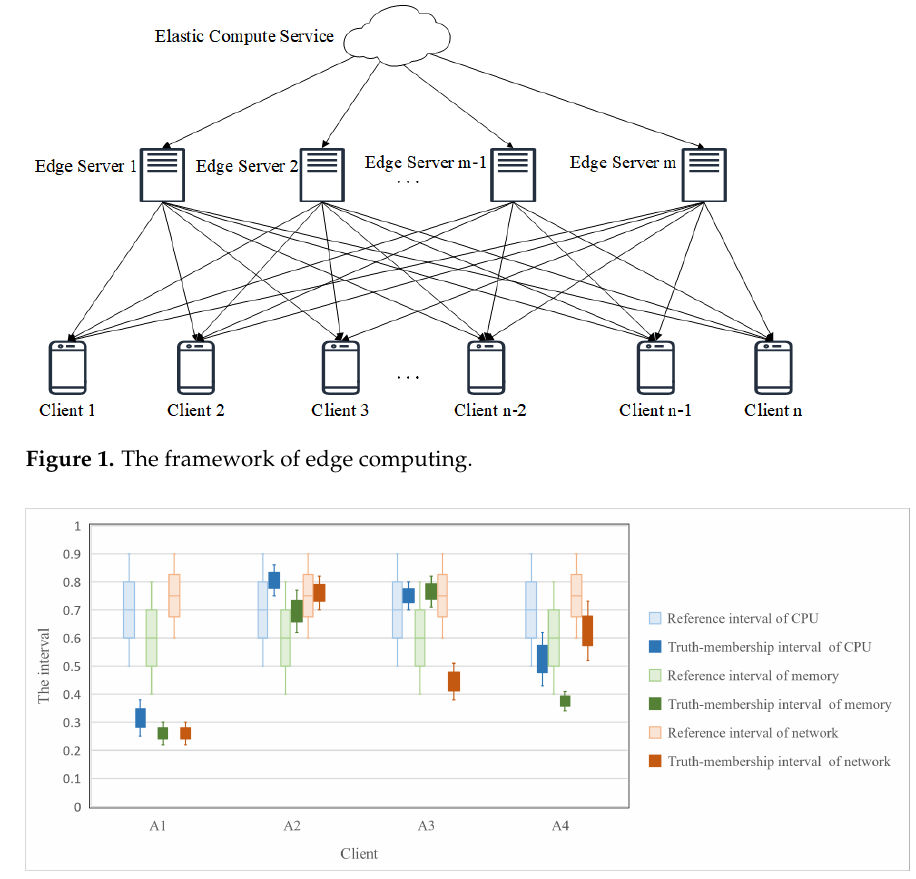
Figure 2. The visualization of the truth-membership interval of clients compared with the reference interval of three